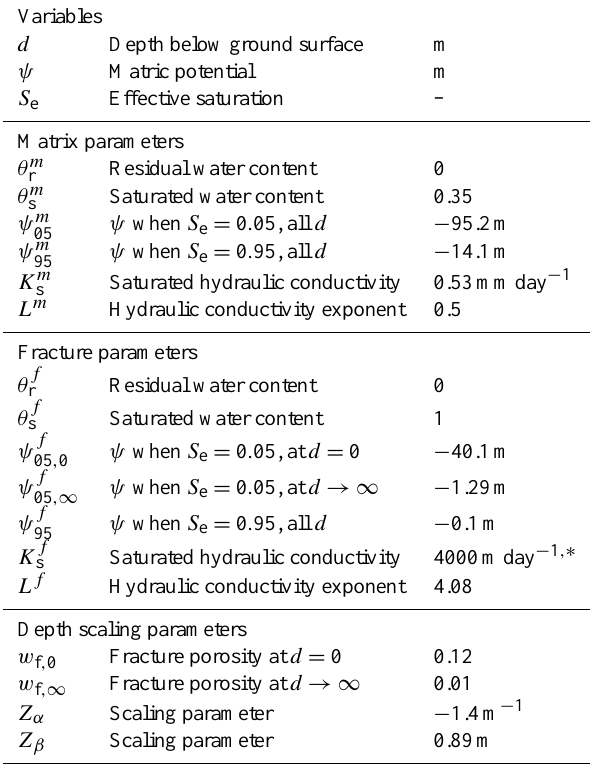
Table 2. Richards’ equation model